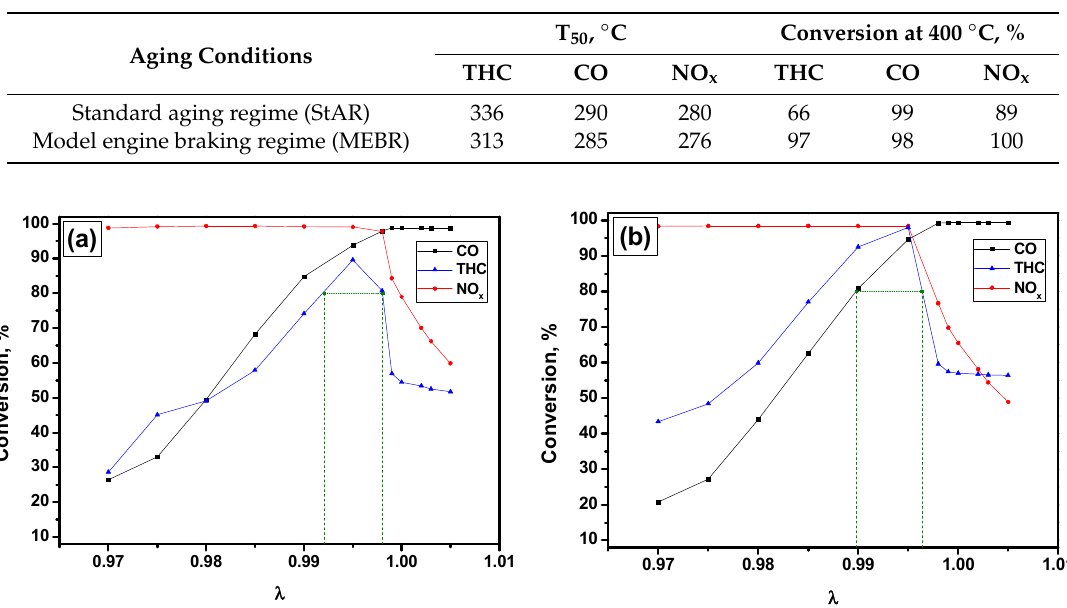
Figure 3. Operation window of the Rh / (Al 2 O 3 -CeZrO 2 ) catalyst aged at standard conditions ( a ) and in the model engine braking regime ( b ).